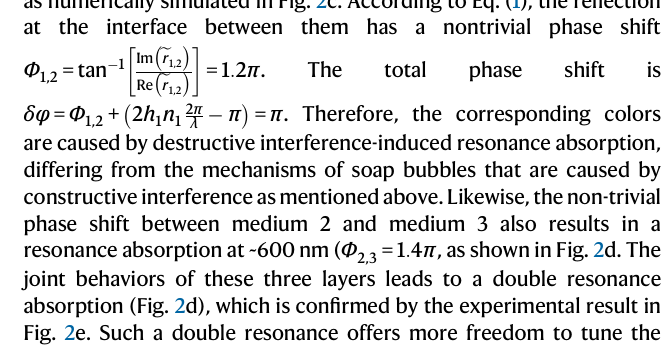
Fig. 2 | Optical properties of TiAlN – TiN hybrid fi lms. a Photograph of surface coloring with various thickness of AlN ( t 1 ) coating subsequent with different thicknessofTiAlNcoatings( t 2 =0,10,15,25,35,50inunitofnm)on t 3 =50nmTiN. The substrates are 2-in. Si wafers. On each sample, three different thickness of AlN are employed: top t 1 =0; middle t 1 =25nm; bottom t 1 =50nm. Please note that masks were used to change the thickness of AlN in different areas during fi lm